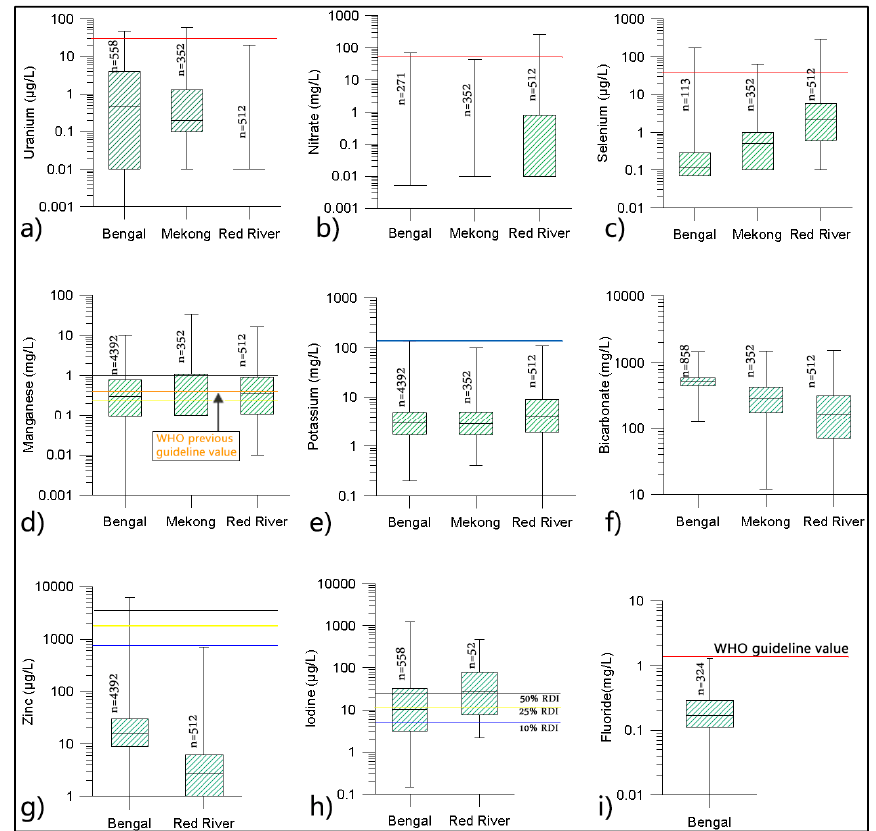
Figure 5. Basic statistical properties (minimum, maximum, median, lower quartile and upper quartile) for various groundwater ions from the deltas are shown in the box plots.